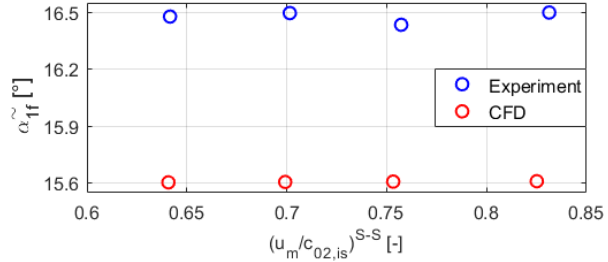
Figure 9. Mass-averaged nozzle output absolute velocity angle at mid radius.